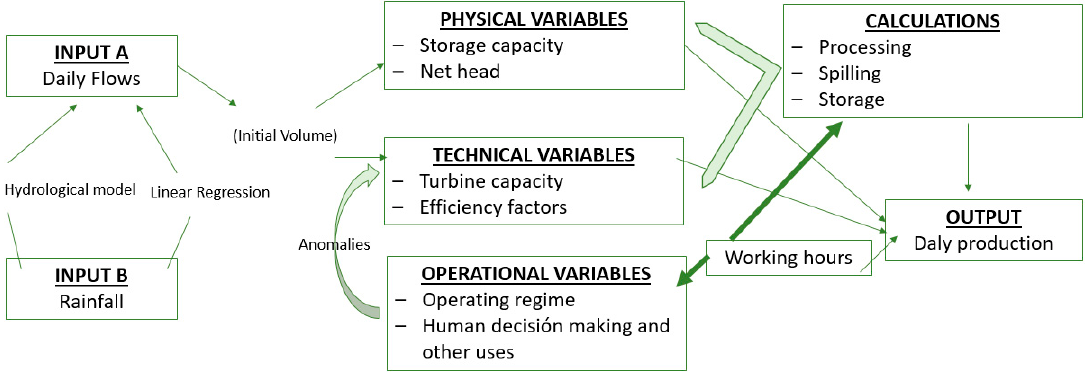
Figure 2. Operation of HydroClim Physical Model.